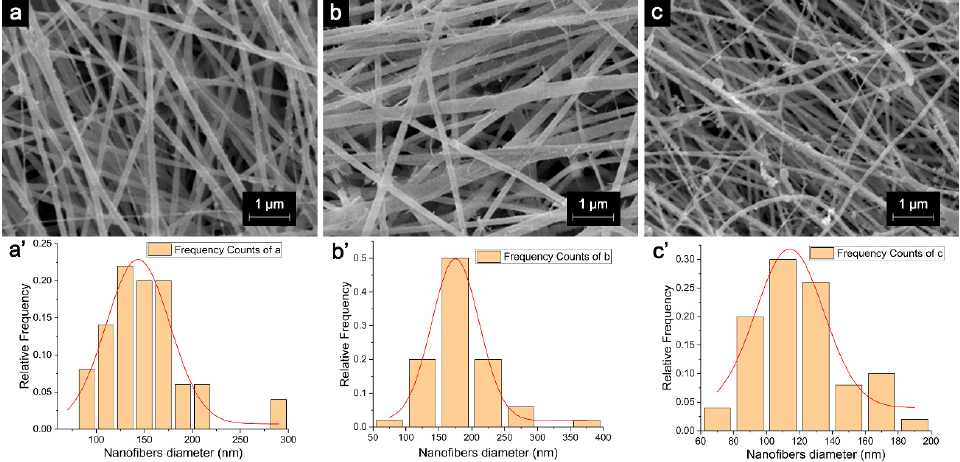
Figure 4. SEM micrographs and diameter distribution histograms of ( a , a’ ) PEO/PVA nanofibrous mats, ( b , b’ ) HHK/PEO/PVA nanofibrous mats and ( c , c’ ) AgNP-HHK/PEO/PVA nanofibrous mats.